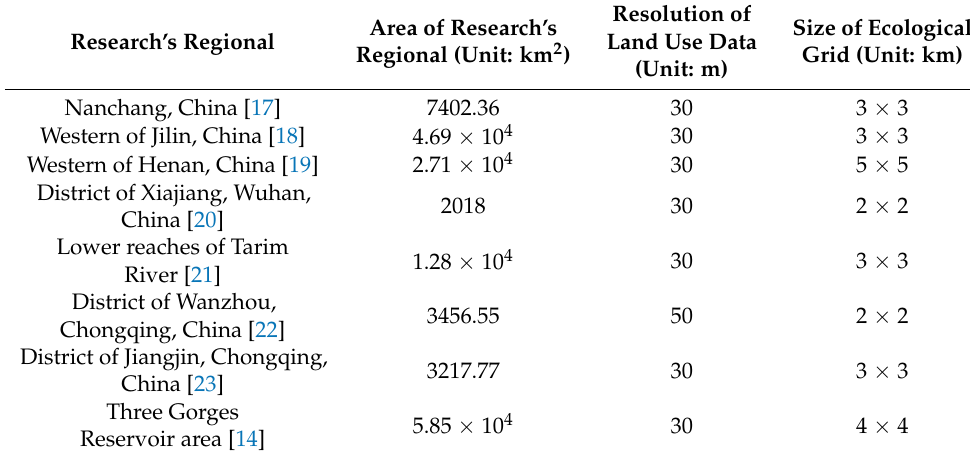
Table 1. The size of ecological grid used in previous